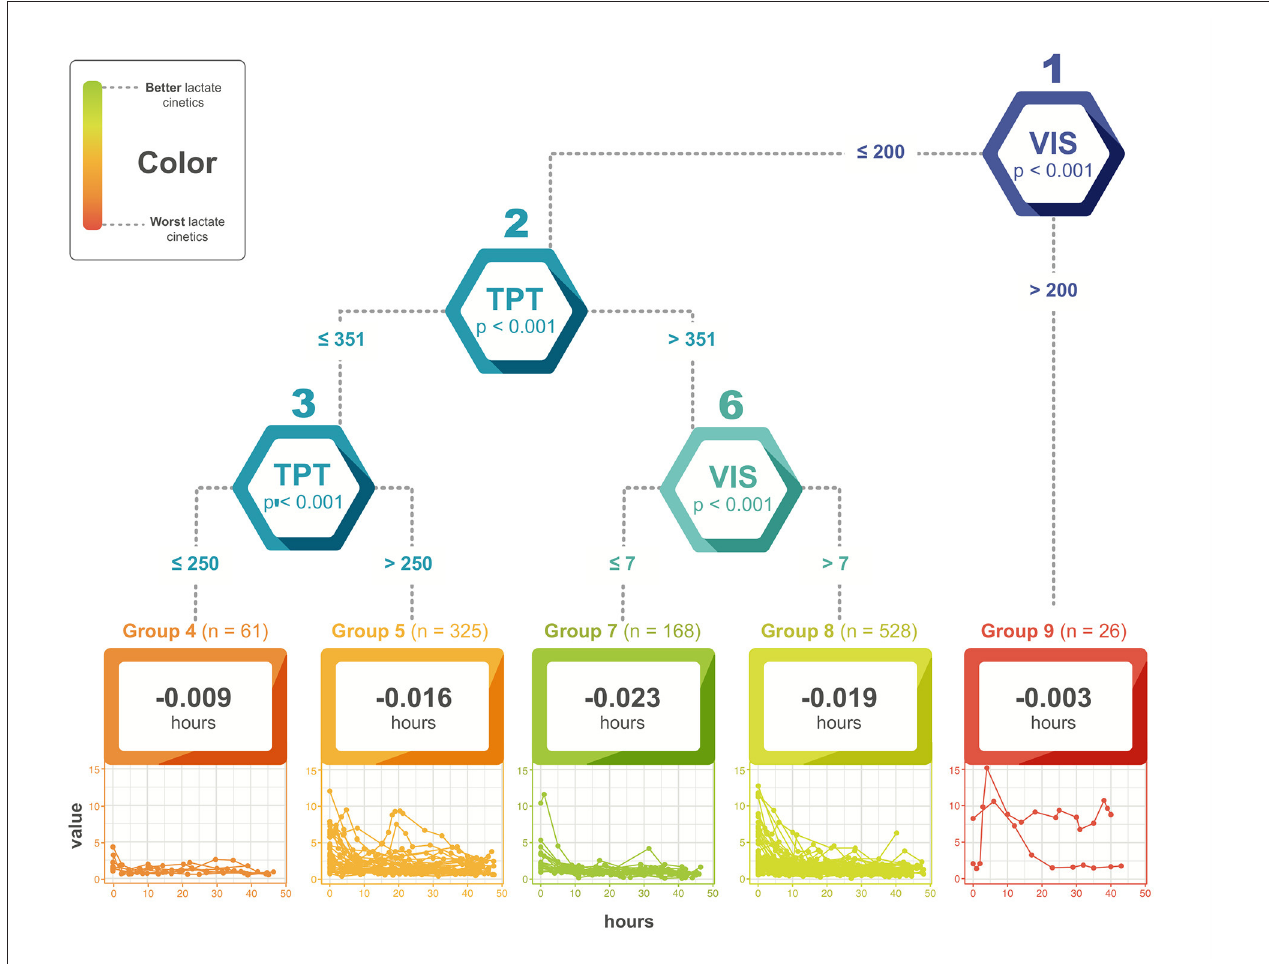
FIGURE 4 | Relationship between vasoactive-inotropic score, total procedure time and lactate levels. VIS, vasoactive-inotropic score; TPT, total procedure